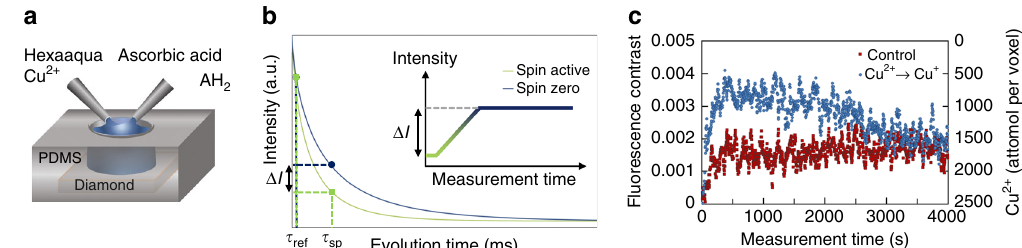
Fig. 5 Monitoring redox kinetics. a Schematic showing the redox reaction of Cu 2+ ions (spin ½ ) to cuprous ions (spin zero) via ascorbic acid at a ratio of 1:1. b Dynamic quantum probe relaxation microscopy using a two point T 1 measurement scheme to detect redox reactions of spin active molecules. The fi rst time point, τ ref , is used to normalise the fl uorescence signal over the entire FOV (50 × 50 µ m) with the second time point τ sp set to the T 1 time of the NV probes. By monitoring the normalised intensity over time, changes in the T 1 rate will manifest as a change in the fl uorescence intensity as shown schematically in the inset of b . c Two-point T 1 measurement showing the control experiment ( red squares ) consisting of a dilution of the Cu 2+ from 100 mM to 50 mM with water and the reduction of Cu 2+ using ascorbic acid ( blue circles ). The Cu + is found to disproportionate/re-oxidise over a period of 1 h. The fl uorescence intensity was determined from the FOV at measurement intervals of 3 depth. The Cu 2+ spectrum obtained from a region of interest (ROI) of 1.6 × 1.6 µ m 2 is shown in Fig. 3b ( green circles ) and is in